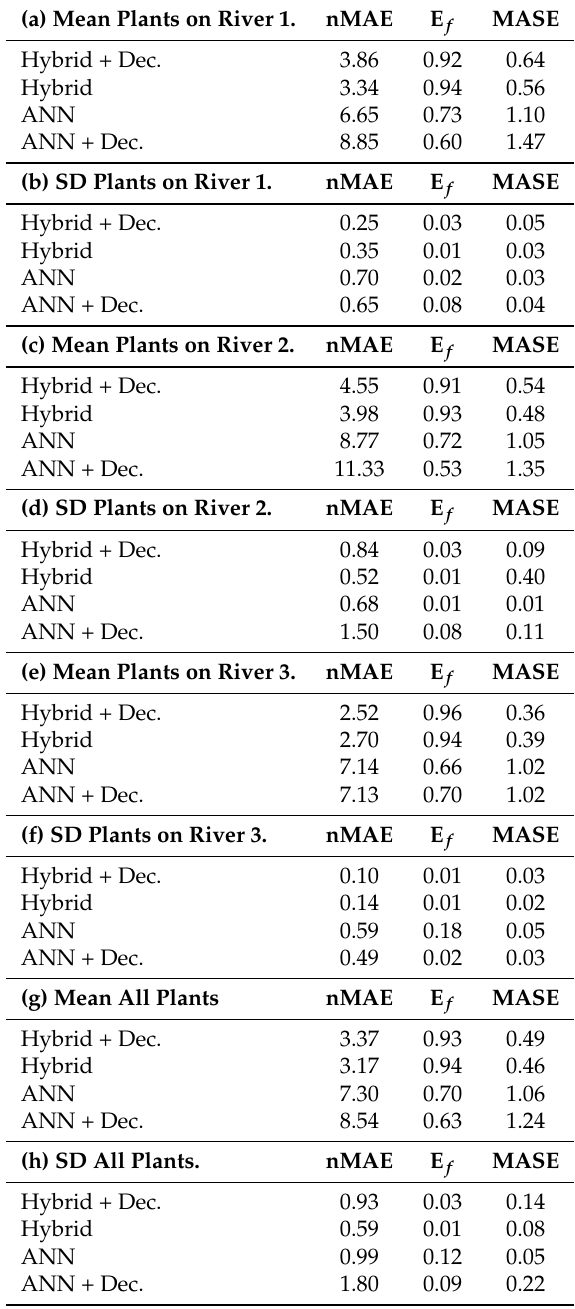
Table 4. Mean performance and standard deviation (SD) of the methods under analysis: (a) and (b) refer to River 1, (c) and (d) refer to River 2, (e) and (f) refer to River 3 while (g) and (h) report mean and standard deviation of all the plants